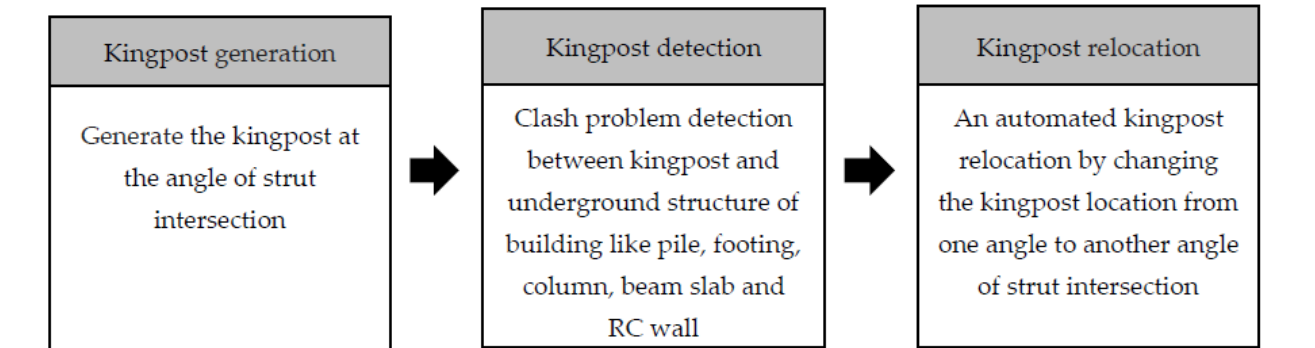
Figure 10. Three main stages of the developed system.